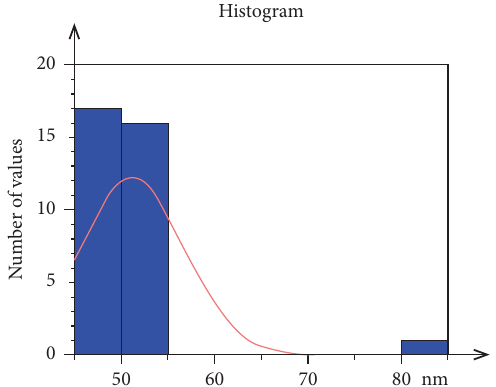
Figure 2: Histogram of the nanoparticles in the colloidal sus- pension explaining the nanoparticles’ size and distribution.